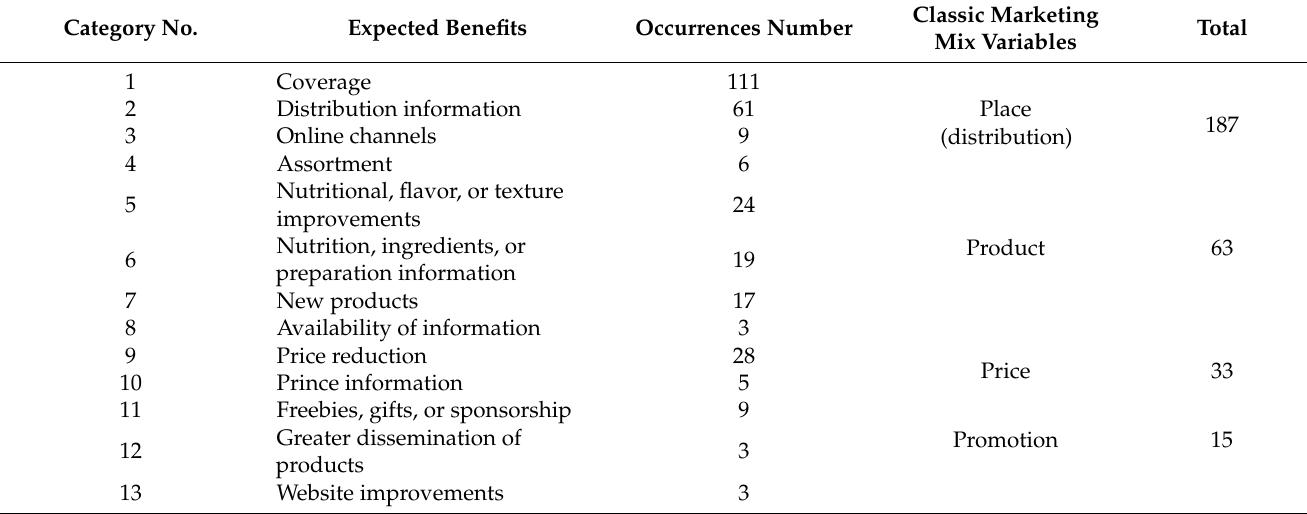
Table 3. Results of the data